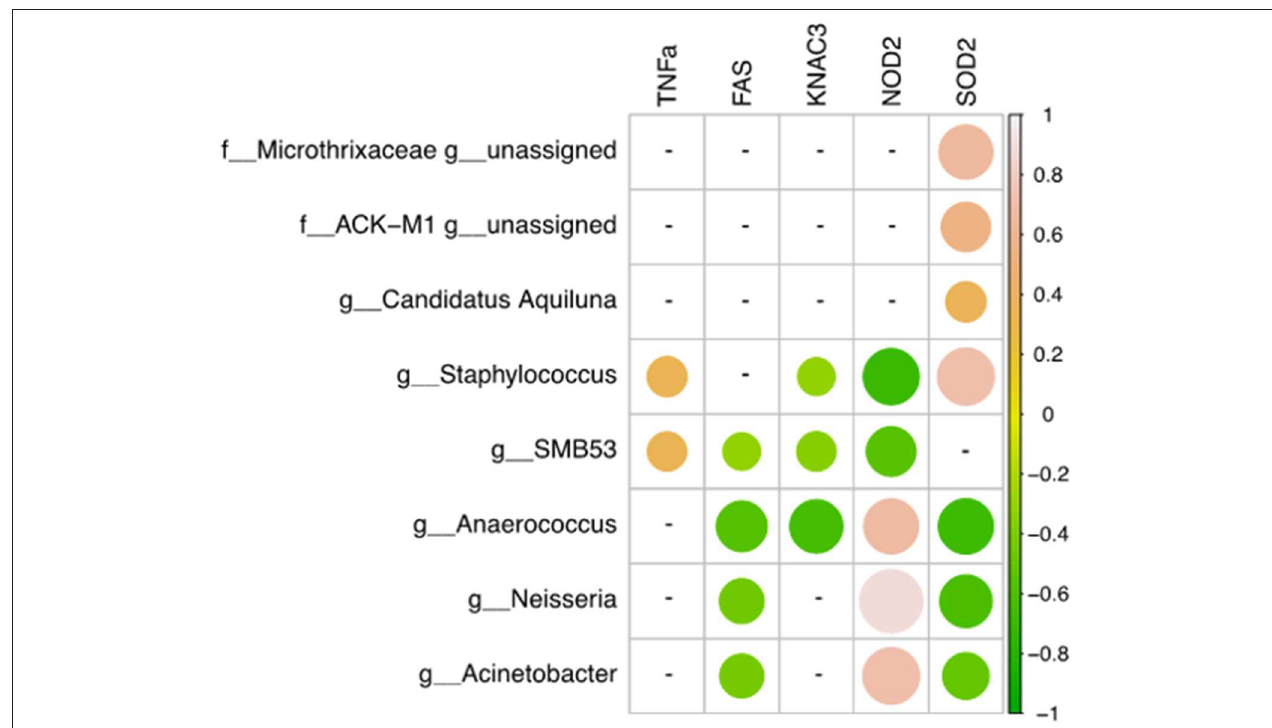
FIGURE 3 | Correlations between human gene expression levels and genera. Pearson correlation values were calculated between human gene expression levels (qRT-PCR) and the percent abundance of genera. The R corrplot package was used to visualize the correlation matrix, which was then reordered using the hclust method in R. The correlation coefficient scale ranges from − 1 (light pink for negative correlations) to 1 (green for positive correlations). Only statistically significant correlation values ( p < 0.05) and with a correlation coefficient |0.3 < r < 1| were plotted.